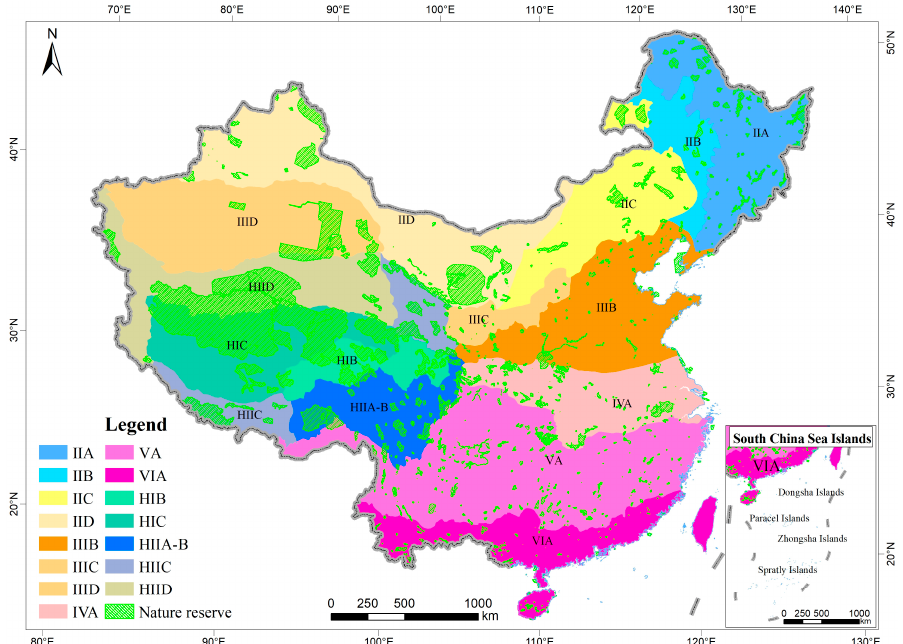
Figure 4. Spatial distribution of the secondary regions of China’s ecogeographical divisions after adjustment. Table 2. The 21 second-level